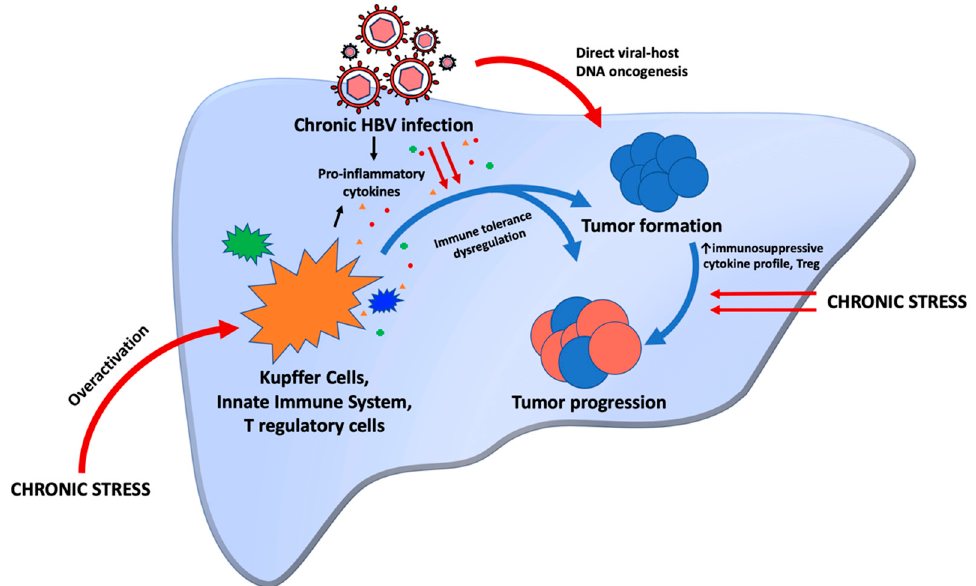
Figure 1. Chronic stress can lead to immune system overactivation, which in combination with chronic HBV infection, leads to immune tolerance dysregulation. Pro-inflammatory cytokines re- leased by immune cells in response to chronic stress and chronic HBV infection also contribute to tolerance dysregulation. This helps tumors to form. HBV DNA also directly integrates into host DNA, another oncogenic mechanism in the formation of tumors. Once a tumor is formed, chronic stress can also switch cytokine profiles to more immunosuppressive ones that allow for the tumor to progress.